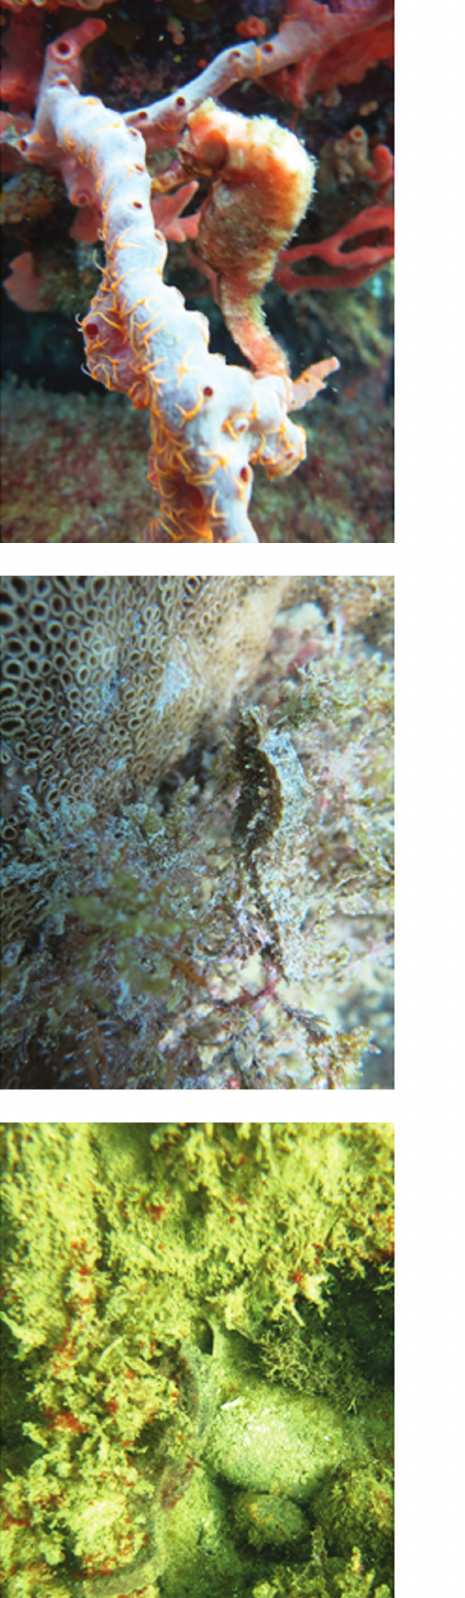
Fig. 4. Plain-colored (Left column) seahorses occupy similar background color, while banded disruptive seahorses (Right column) occupy more diverse